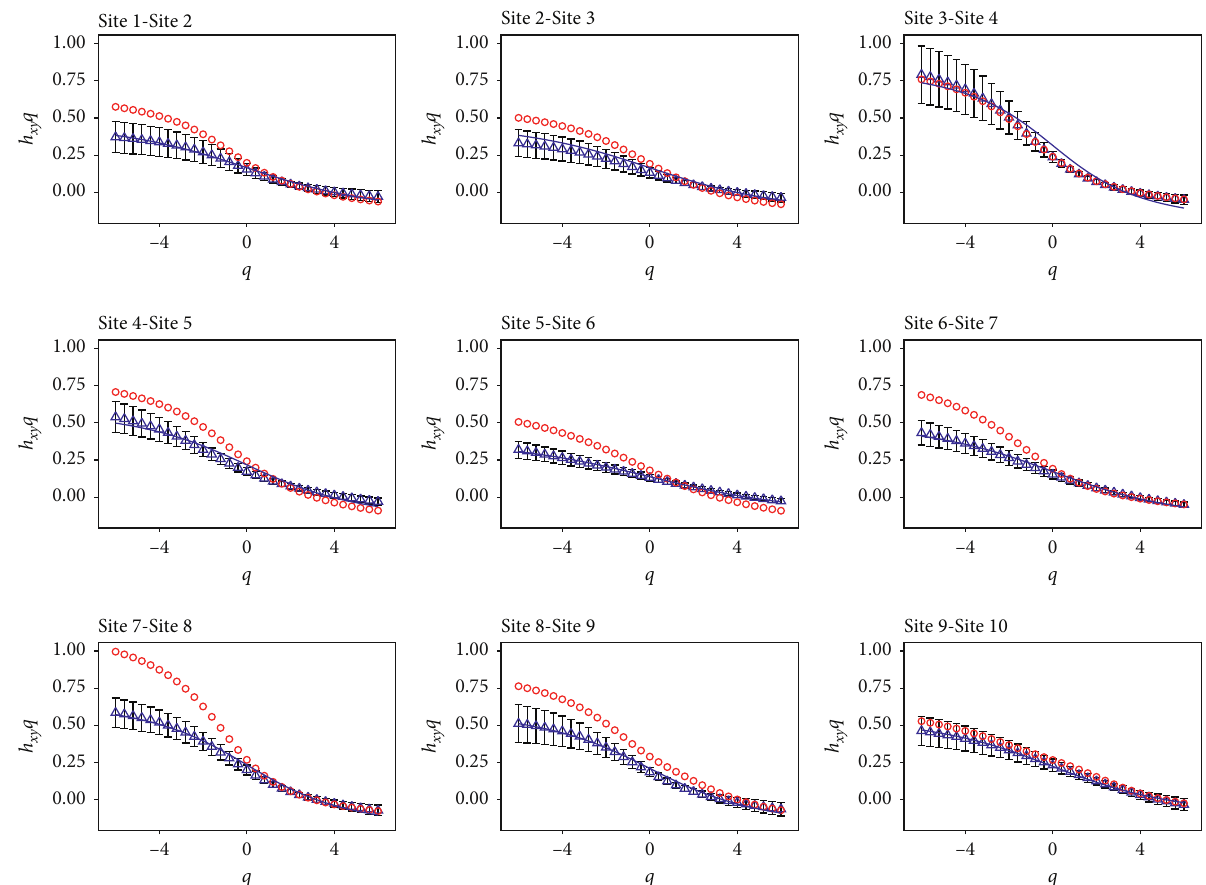
Figure 3: Comparison of values of h ( q ) and (( h ( q ) + h ( q )) /2 ) for two preprocessed daily average river levels at adjacent sites. Different XY X Y colors and symbols indicate the corresponding different results: blue triangles for values of h XY ( q ) and red circles for values of (( h ( q ) + h ( q )) /2 ) . The curves are obtained by fitting the two-parameter binomial model (equation (10)) to points of h X Y model parameters are reported in Table 2. The errors bars of h XY ( q ) are based on the linear least square fit. All the errors bars reveal 95% confidence